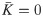
Effects of interlaminar connections on a pair of wandering bumps (model A).Overlaid lines represent the trajectories of the center-of-mass or phase of the bumps, β1(t) and β2(t). (a, b) Plots of wandering bump in network 1 for zero (K¯=0) and nonzero (K¯=2) interlaminar connections, respectively. (c, d) Analogous plots for network 2. The two networks are taken to be identical with the same parameters as Fig 2 except h¯=0.2. (e-h) Same as Fig. 6 except that h1¯=2.0, h¯2=0.25 and K¯=0.1 in (b, d).